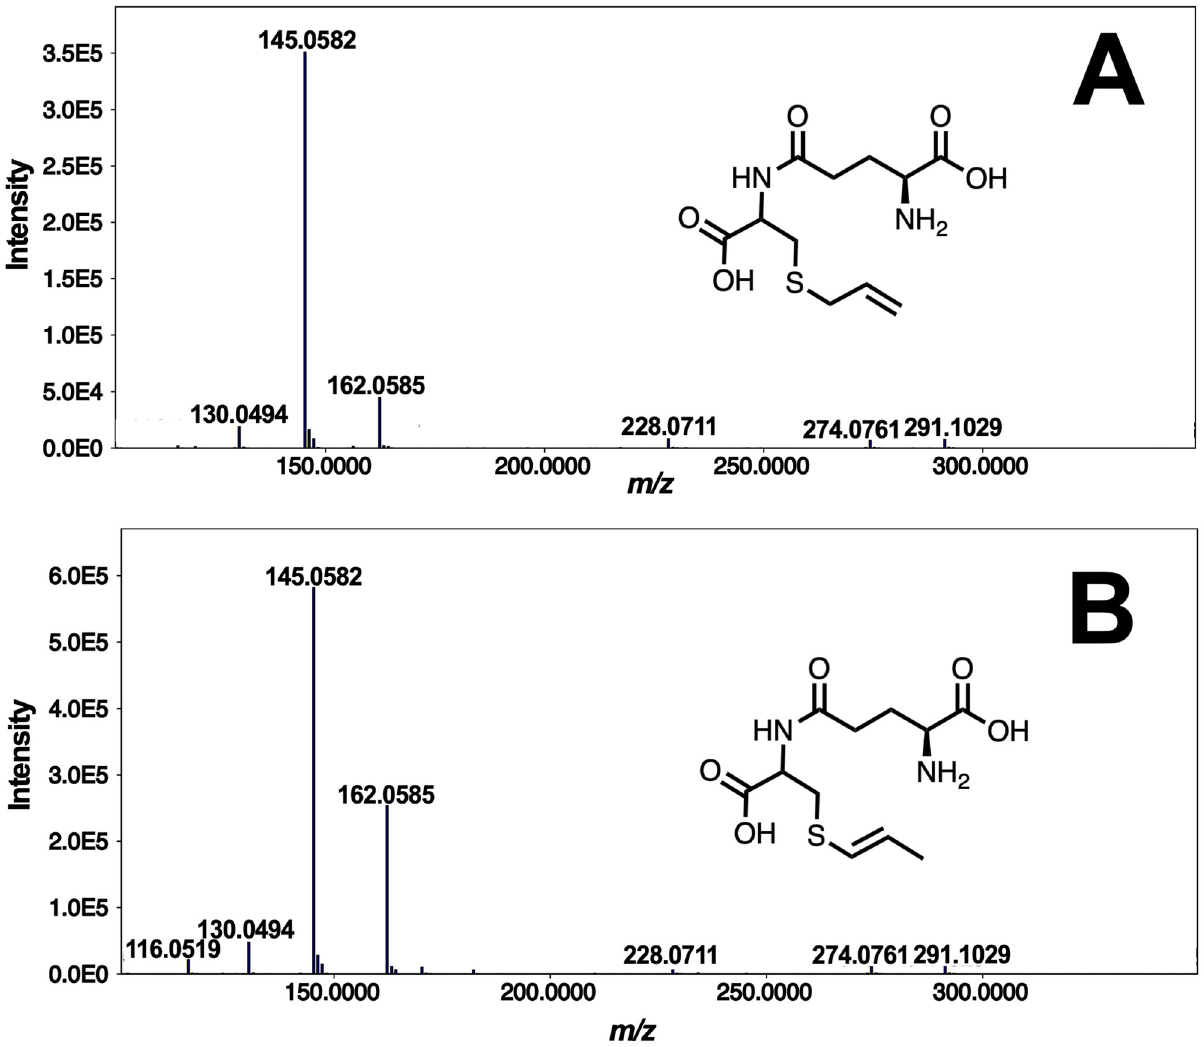
Fig 2. MS 2 spectra of isobaric features with m/z 291.10 annotated as γ -glutamyl allyl cysteine and γ -glutamyl propenyl cysteine. Spectrum A was characterized as γ -glutamyl allyl cysteine while spectrum B is associated with its positional isomer, γ -glutamyl propenyl cysteine (t R = 1.59 mins).